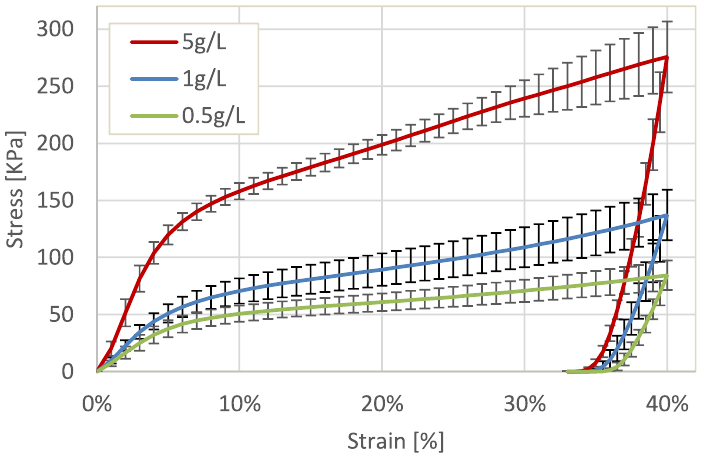
Figure 1. Averaged stress-strain characteristics for alginate aerogel samples synthesised with different CaCl 2